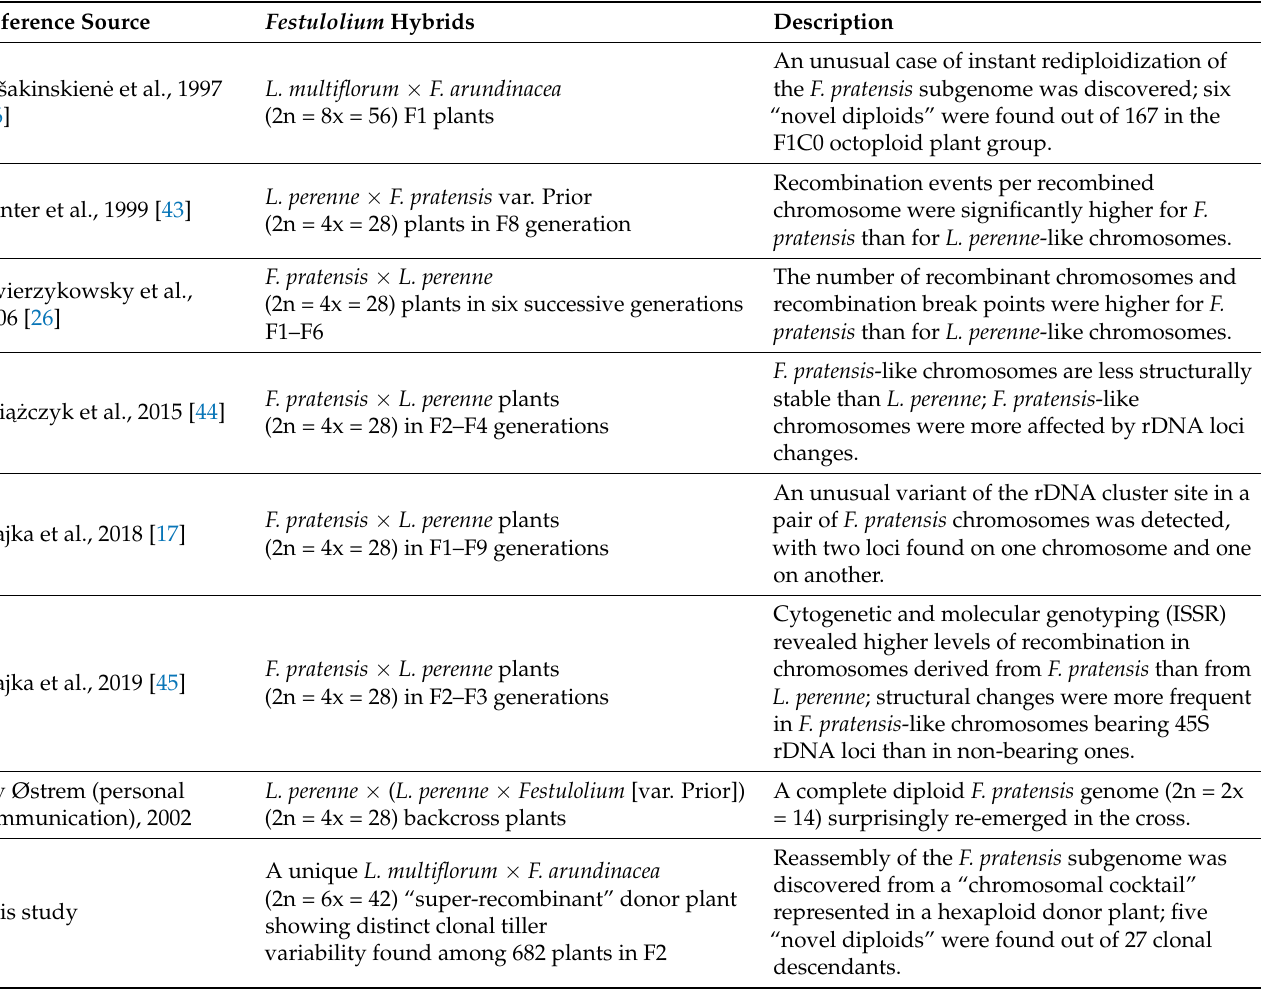
Table 4. Summarized data on F. pratensis apparent feature for marked chromosomal structural changes in Festulolium